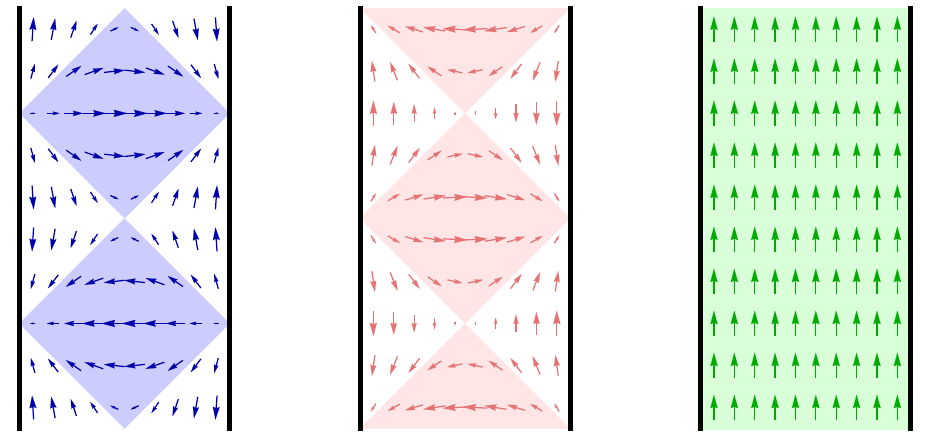
Figure 1 . The three Killing vectors: boost B (blue), momentum P (pink), and global energy E (green) given in (2.5) in the coordinate system (2.6a). The shaded regions delineate di(cid:11)erent orbits of the